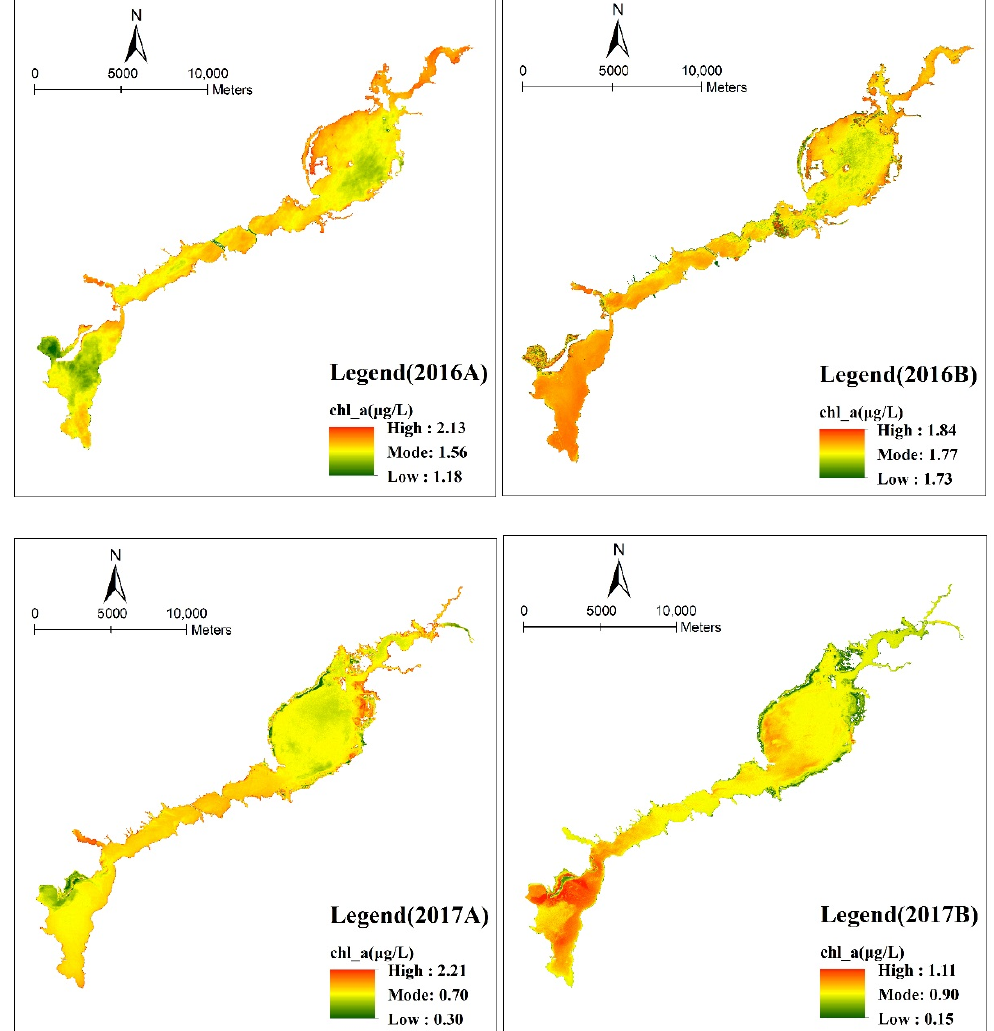
Figure 3. Distribution of chlorophyll-a concentrations of Landsat-8 OLI (2016A, 2017A) and Sentinel-2A (2016B, 2017B) in the Guanting Reservoir in 2016 and 2017. The color bar indicates the closeness of the concentration value to the mode. Red indicates values exceeding the mode, while green indicates values below the mode.